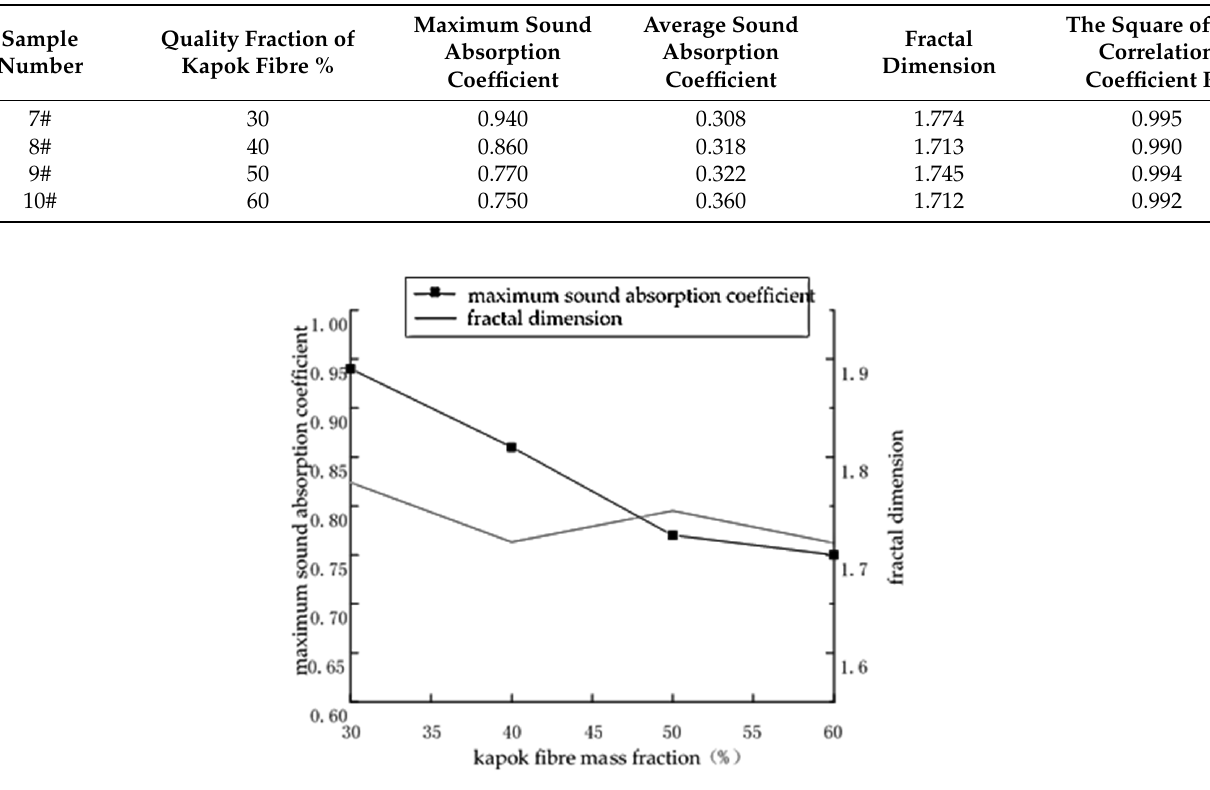
Figure 9. Relationship between sample fractal dimension and maximum sound-absorption coefficient under different kapok fibre mass fractions .